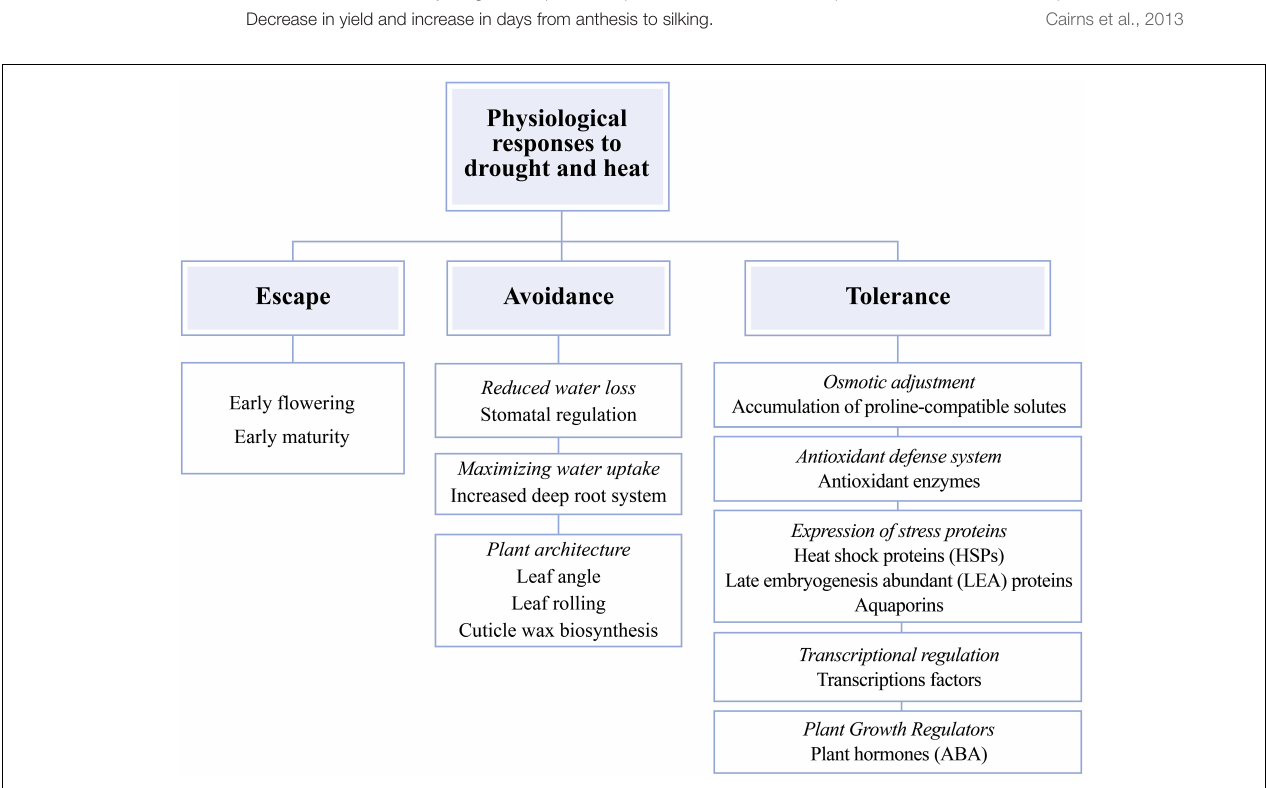
FIGURE 1 | Mechanisms of morphological, physiological, biochemical, and molecular responses to the combination of drought and heat in maize ( Zea mays L.) plants. Adapted from Aslam et al. (2015) and Tiwari and Yadav (2019). Words in italics represent physiological, biochemical and molecular plant mechanisms, non-italicized words represent biological processes affected by abiotic